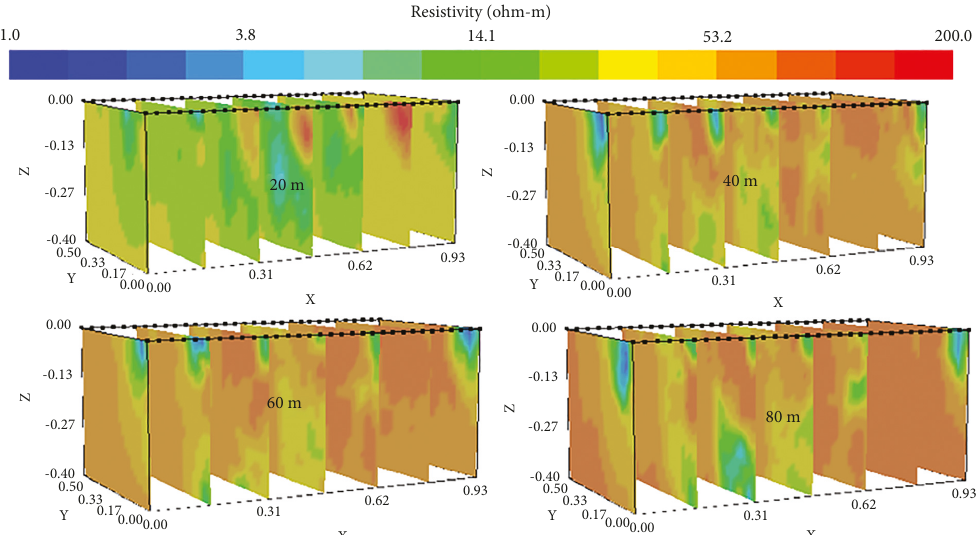
Figure 12: The resistivity section diagram along the x -axis direction at 40 cm above the coal